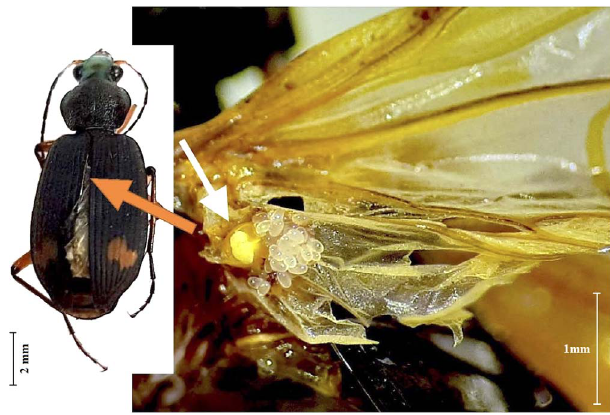
Figure 13. Eutarsopolipus chlaenii n. sp. under the elytra of the host beetle Chlaenius fl aviguttatus Macleay, 1825, localized on the proximal portion of the host ’ s hindwing, with view of the mite ’ s engorged female (yellow colour) producing eggs (milky